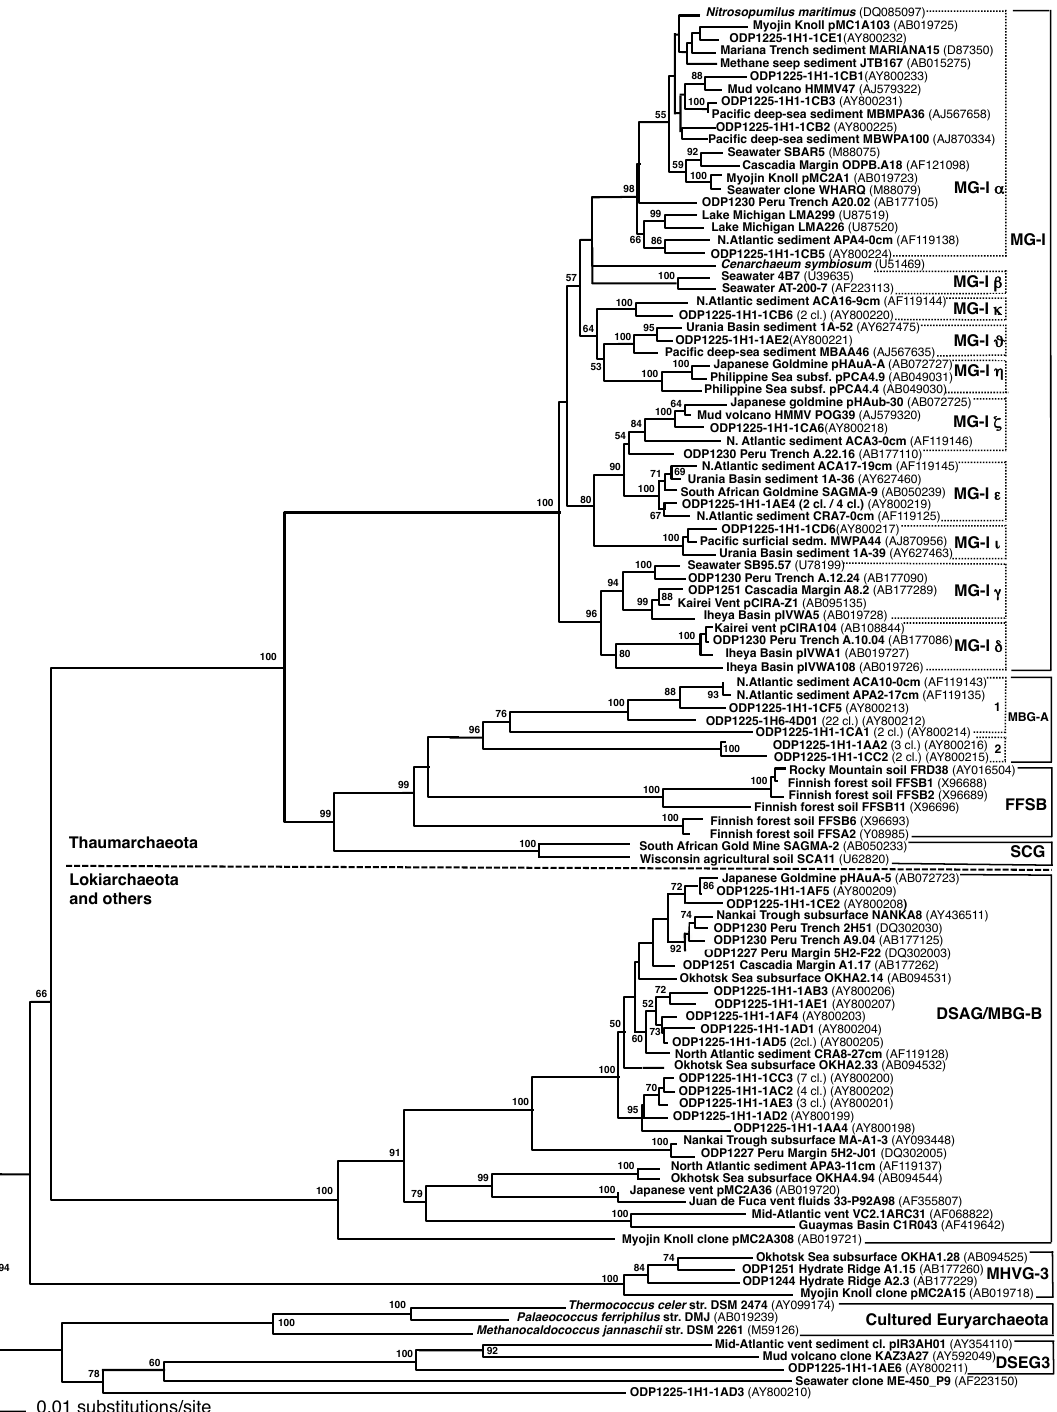
Figure 2. Phylogenetic tree (minimum evolution) of archaeal 16S rRNA genes ( E. coli positions 25–914) from clone libraries of sediment samples 1225C-1H1 and 1H6. Sequences in the phylogeny that represent multiple clones are annotated with clone numbers in parentheses, between clone name and GenBank number. The annotation “2 cl/4 cl” indicates that clone ODP 1225-1H1-1AE4 stands for 2 clones obtained from sample 1225-1H1 and 4 clones from sample 1225-1H6. Bootstrap numbers are based on 200 resamplings. Euryarchaeota (cultured euryarchaeota and the euryarchaeotal lineage DSEG3) were placed as the